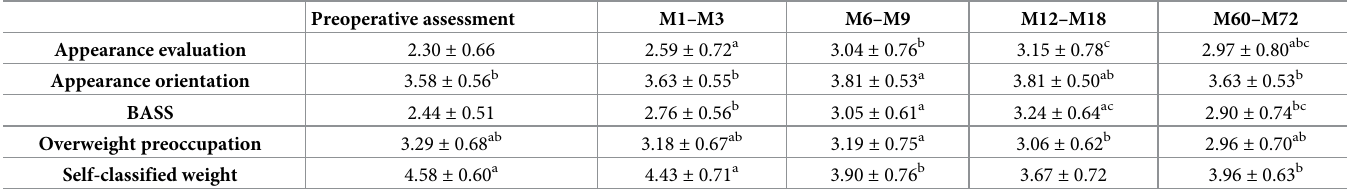
Table 2. The MBSRQ-AS scores (mean ± SEM) during follow-up. Means with different superscripts are significantly different from each other ( P <